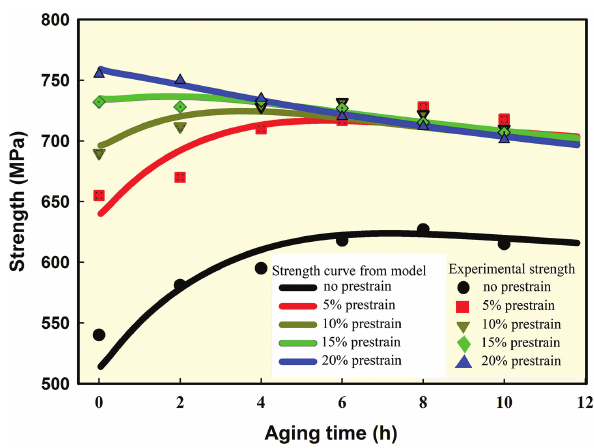
Figure 7: Calculated strength lines and experimental yield strength of Ti – 2.5Cu alloy after duplex aging. All samples were first aged at 673 K for 24